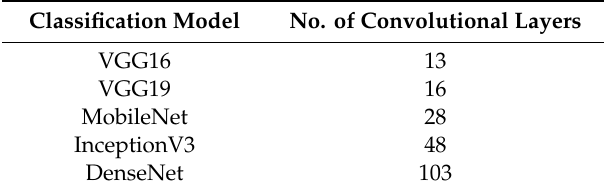
Table 1. Pretrained models and their number of convolutional